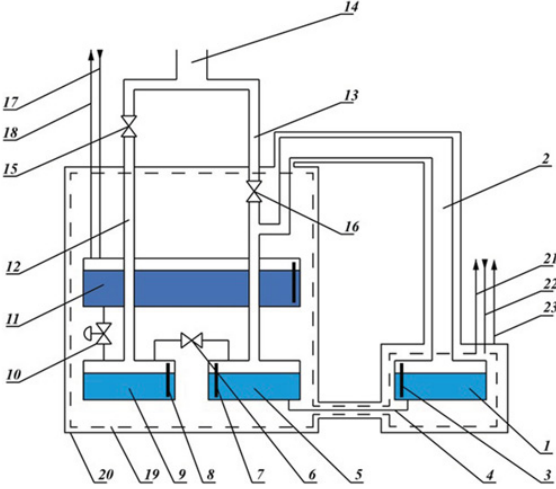
Figure 6. Schematic of the cryostat. See text for explanation of the numbered components. Table 1. UCN source model electric power consumption.